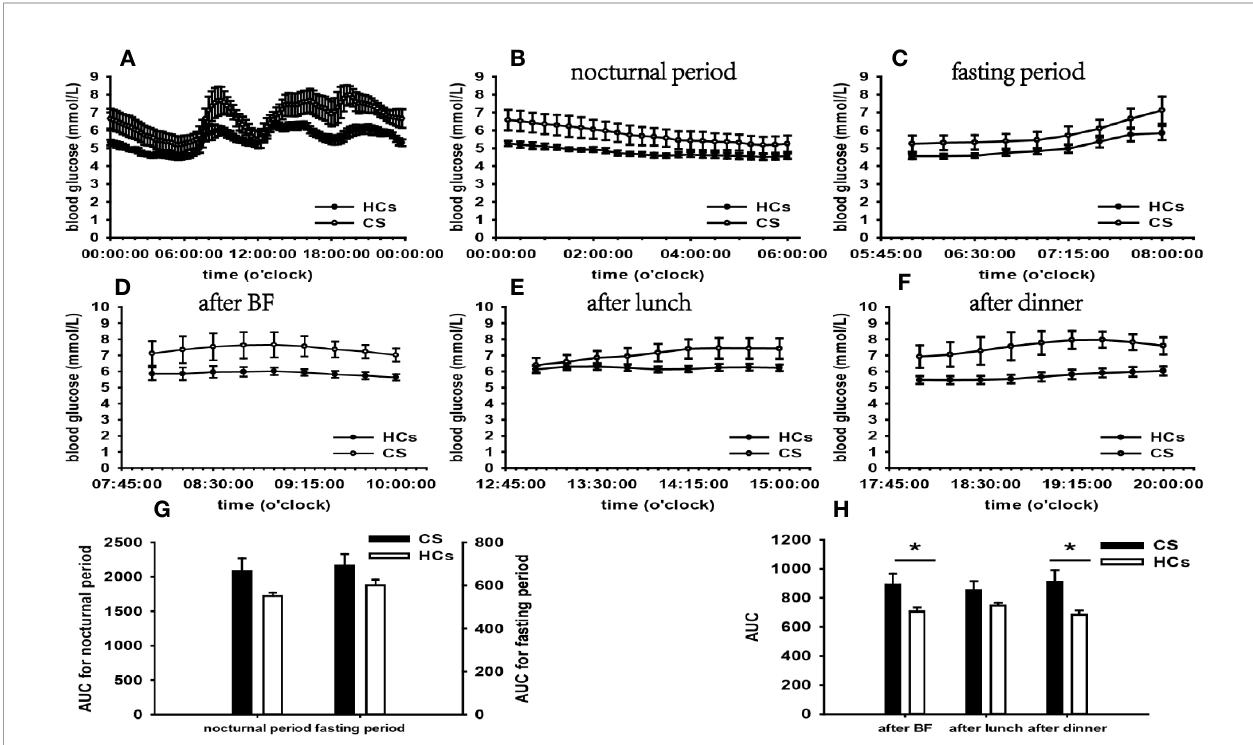
FIGURE 2 | Comparison of the mean blood glucose level and AUC between the CS group and HCs. Mean blood glucose level: (A) at each time point during the day; (B) at nocturnal period; (C) at fasting period; (D) after BF; (E) after lunch; (F) after dinner. AUC: (G) at nocturnal and fasting periods; (H) at postprandial periods. * represents signi fi cant difference between CS and HCs. The data were showed as mean ± SEM. AUC, area under the curve; CS, Cushing syndrome; HCs, healthy controls; BF, breakfast; SEM, standard error of